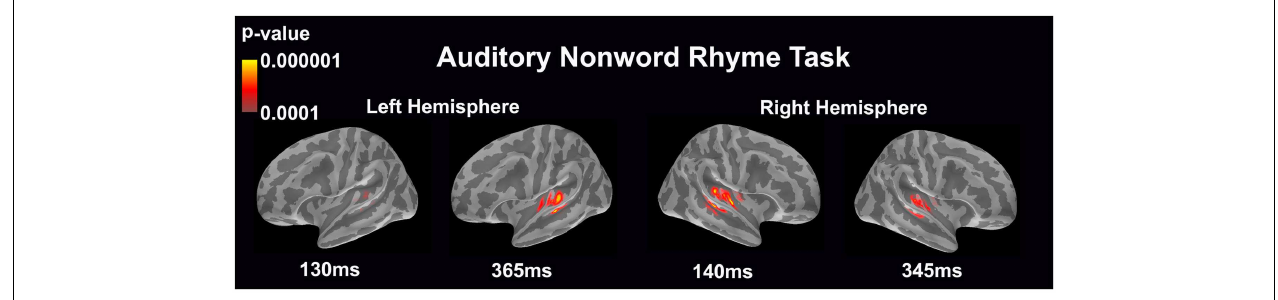
FIGURE 1 | Cortical activation during the auditory non-word rhyme task is shown . Dynamic statistical parameter maps represent cortical activation averaged across 15 children with epilepsy with times representing latency from the onset of the auditory